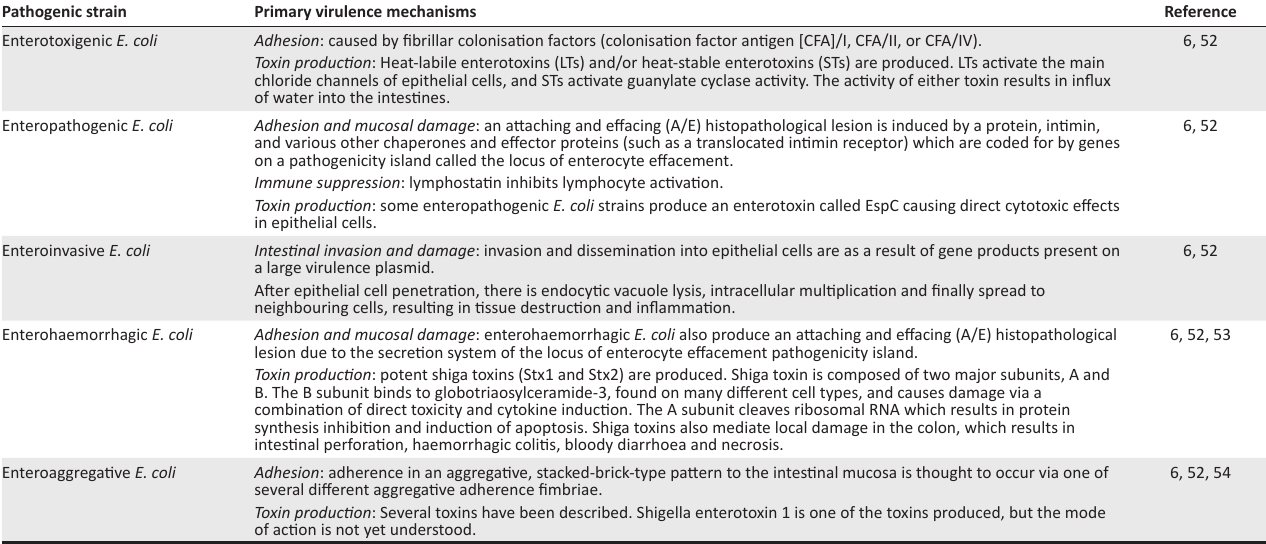
TABLE 4: Mechanisms of virulence in pathogenic Escherichia coli . Pathogenic strain Primary virulence mechanisms